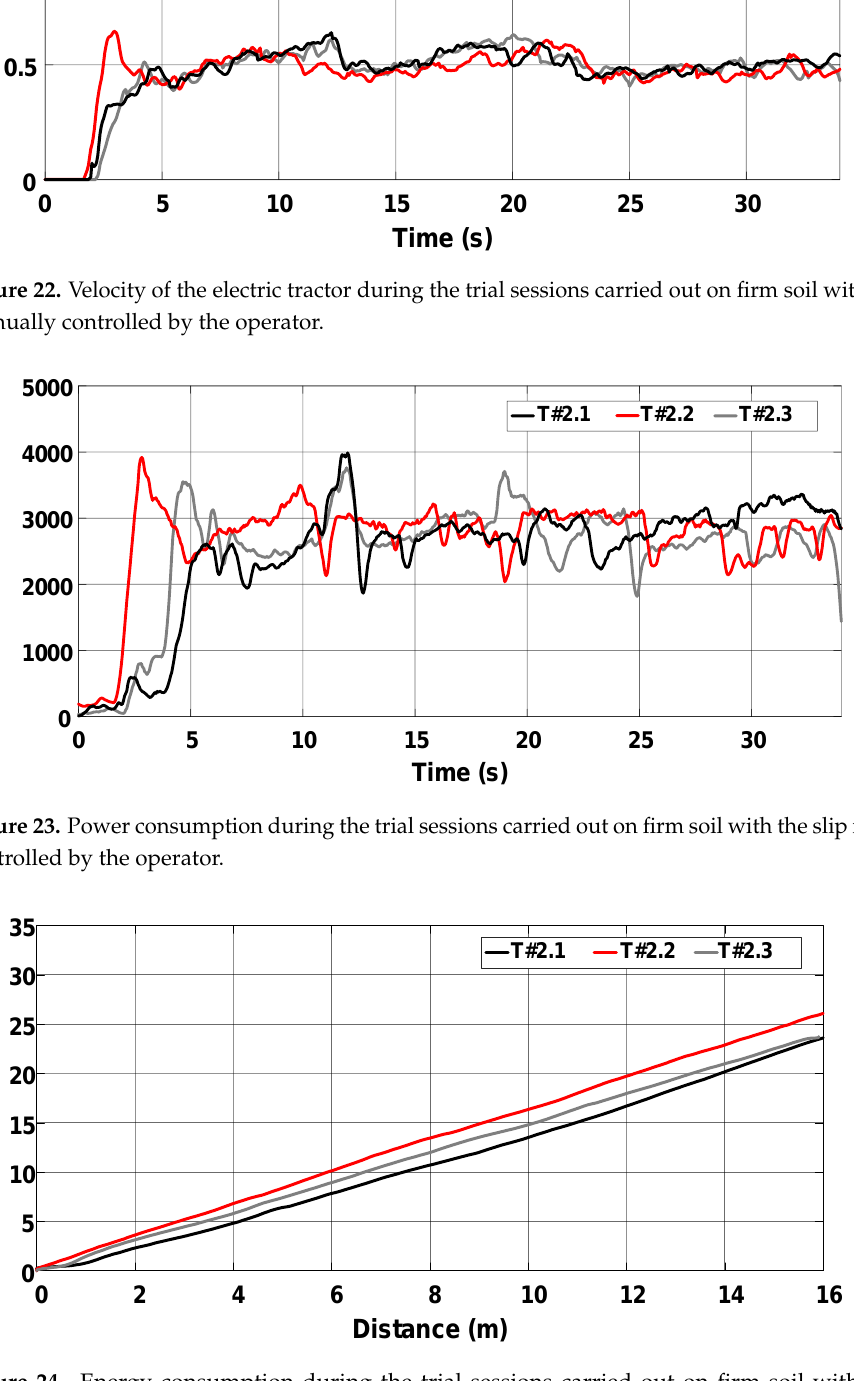
Figure 24. Energy consumption during the trial sessions carried out on firm soil with the slip manually controlled by the operator. Table 2. Summary of parameters measured during the trial sessions carried out on firm soil with the slip manually controlled by the operator.